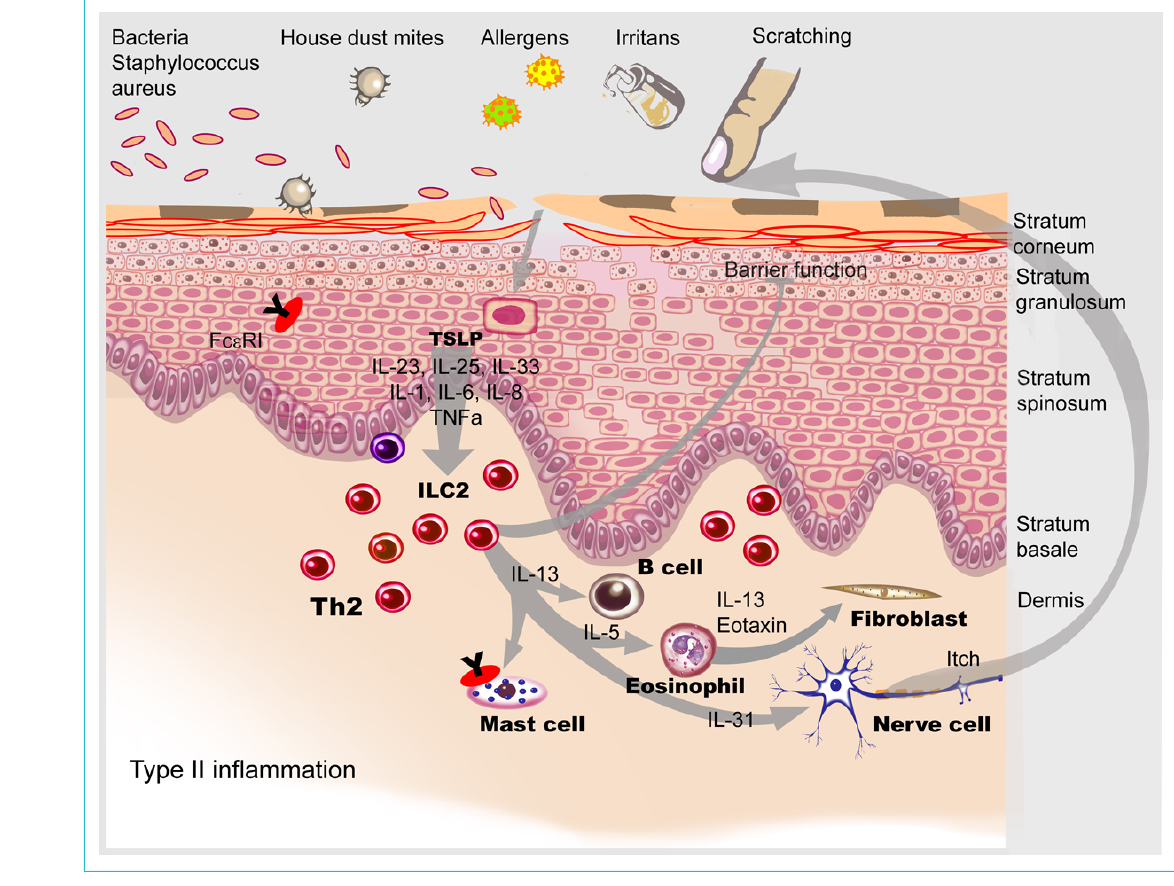
Figure 2: The targets of dupilumab in atopic dermatitis skin characterised by a type 2 immune reaction. Illustration: Aldona von Guten (modi- fied from: Simon D, Wollenberg A, Renz H, Simon HU. Atopic Dermatitis: Collegium Internationale Allergologicum (CIA) Update 2019. Int Arch Allergy Immunol. 2019;178(3):207–18 [1], reprinted with permission from S. Karger AG,